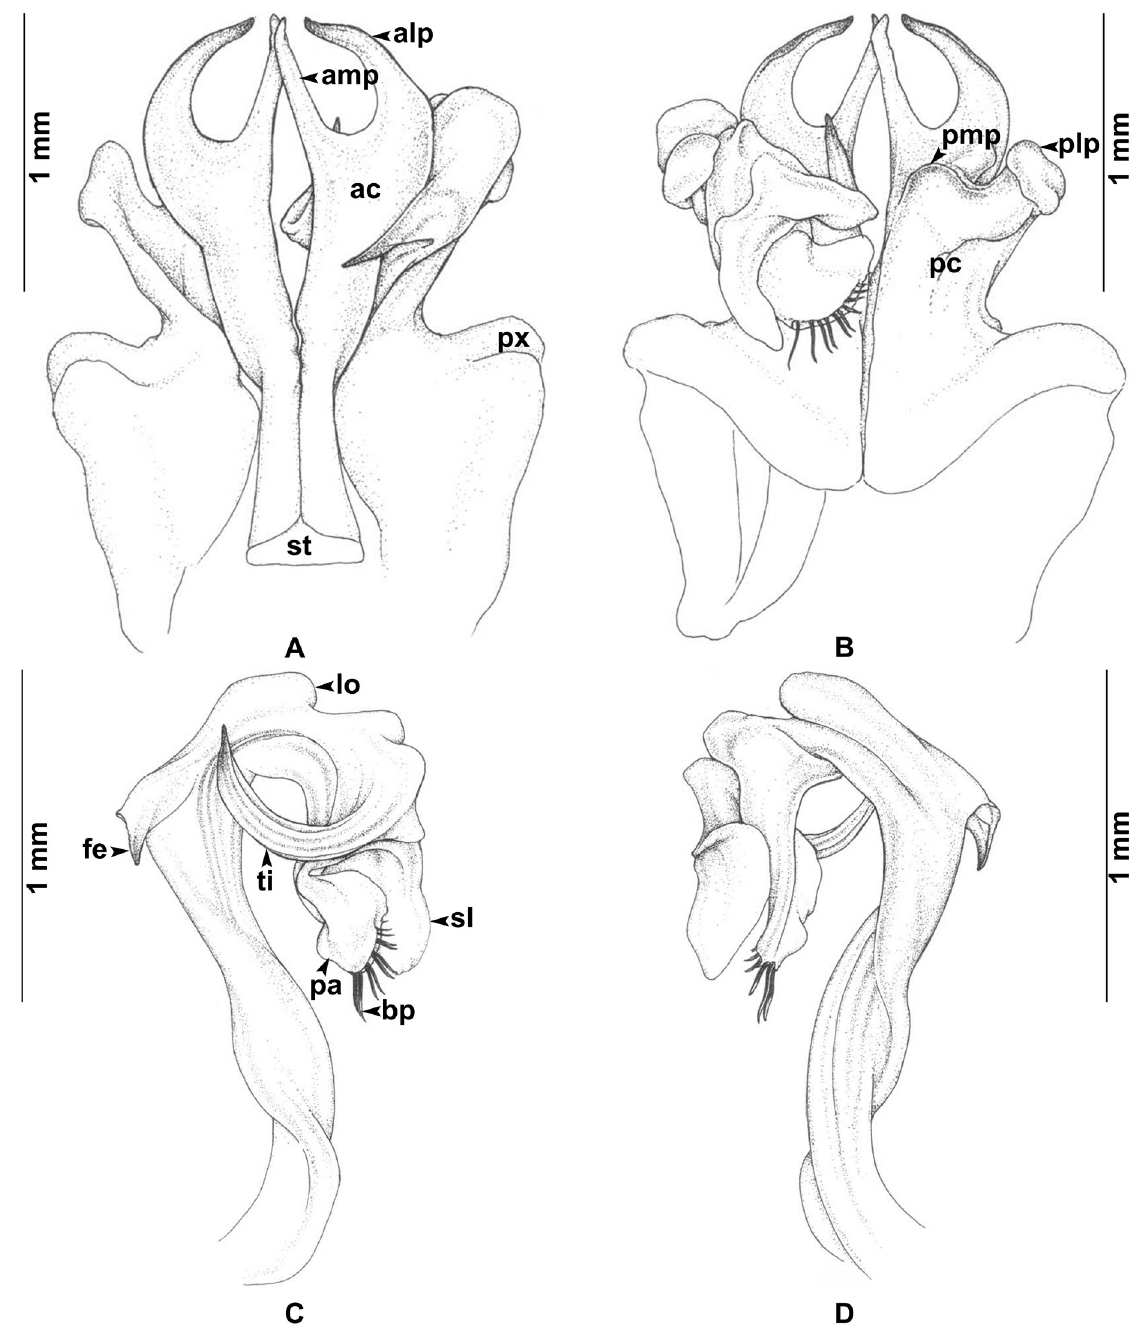
Fig. 8. Thyropygus sutchariti sp. nov., from Kaeng Krachan, holotype (CUMZ-D00090), ♂, gonopods. A . Anterior view, left telopodite removed. B . Posterior view, left telopodite removed. C . Left telopodite, posterior-mesal view. D . Left telopodite, anterior-lateral